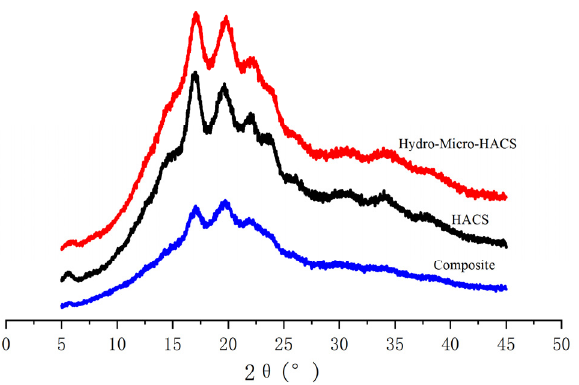
Figure 2. The X-diffraction patterns of the HACS, hydro-micro-HACS, and composite. Different letters following the crystallinity value indicate significant differences ( p < 0.05).